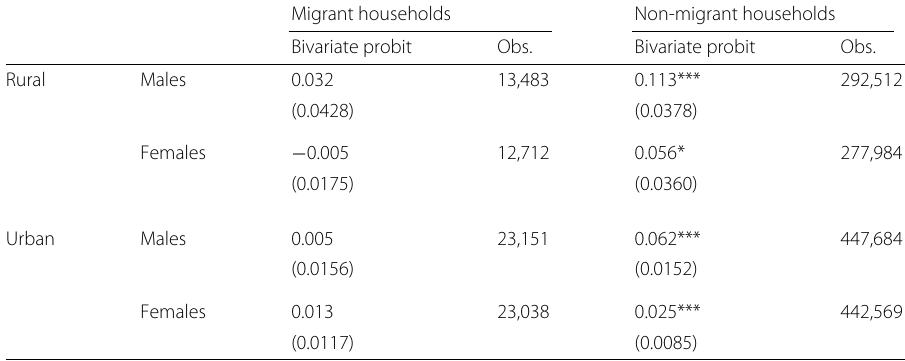
Table 5 By migration status: effects of remittances on secondary school enrollment Migrant households Non-migrant households